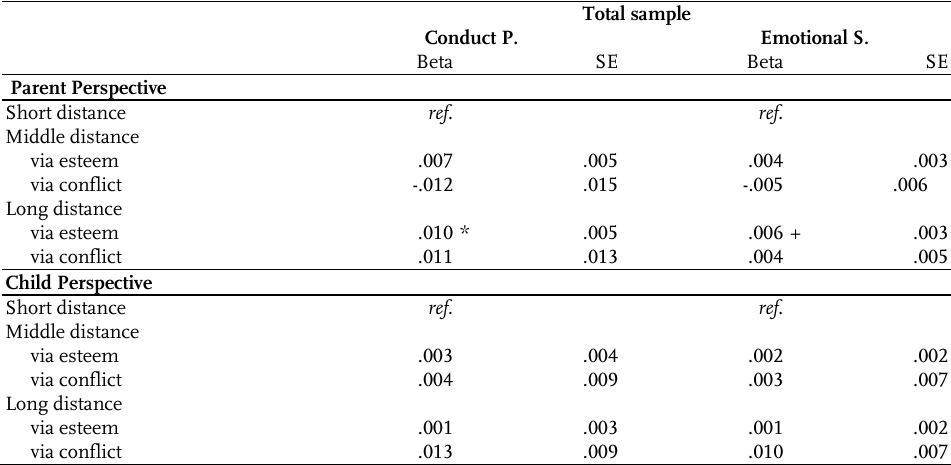
Table 6 : The indirect association between parental long-distance commuting and child well-being via the parent-child relationship Total sample Conduct